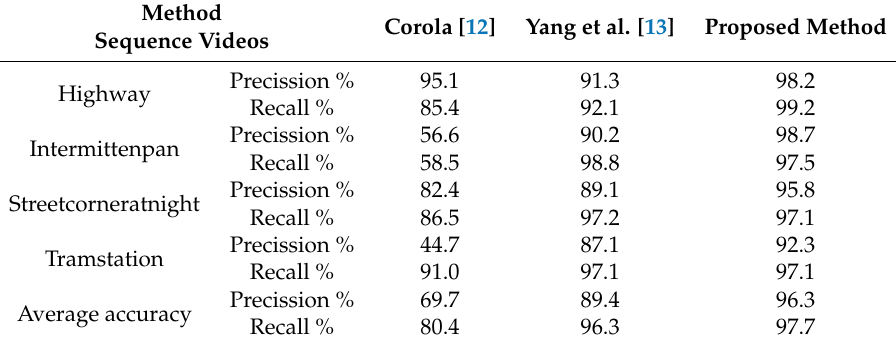
Table 5. Vehicle detection results comparison on CDnet2014